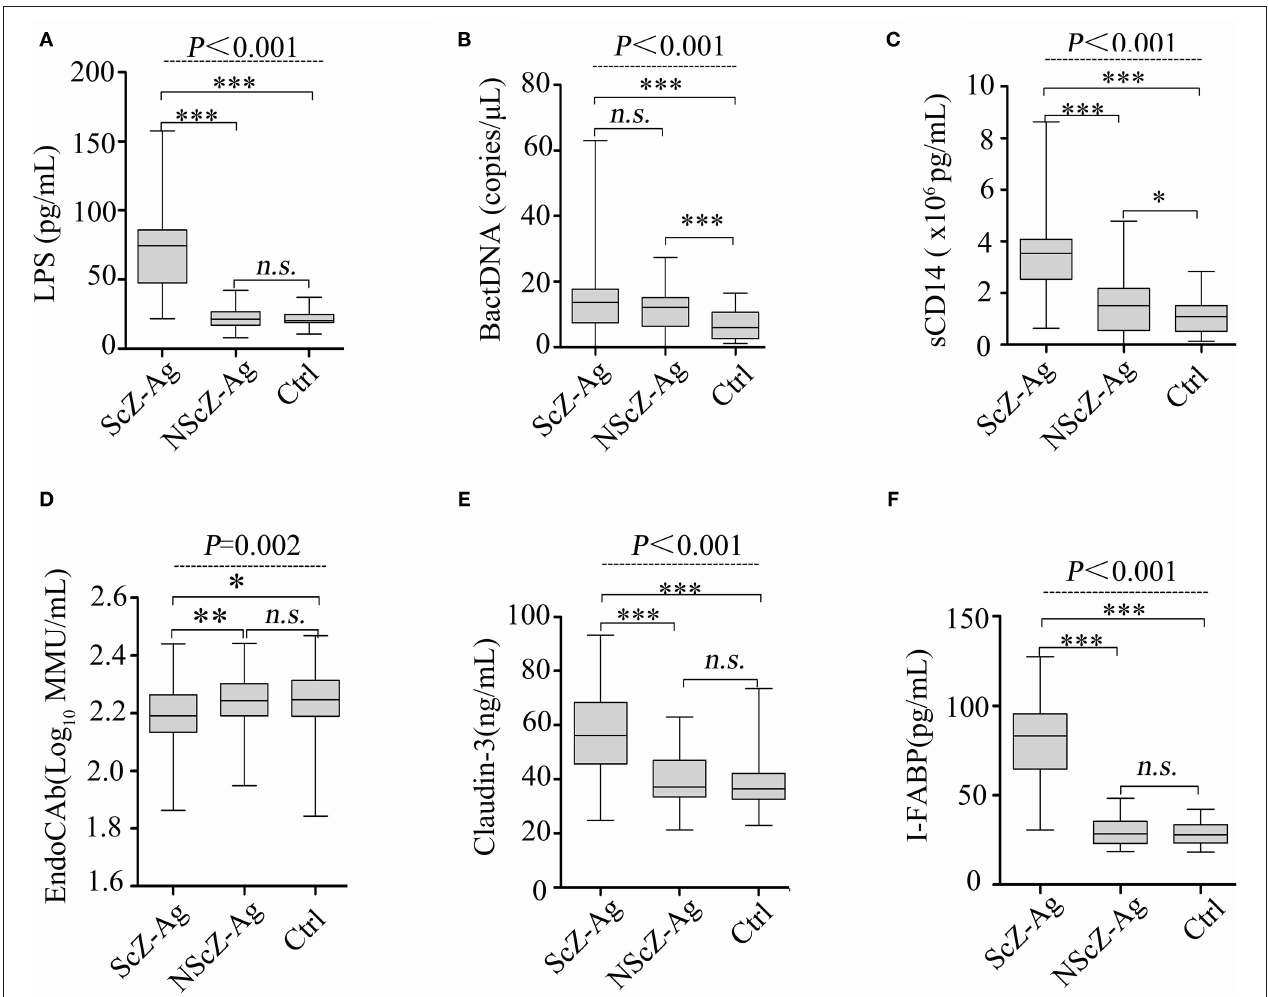
FIGURE 3 | Serum levels of LPS (A) , BactDNA (B) , sCD14 (C) , EndoCAb (D) , Claudin-3 (E) and I-FABP (F) among the three groups. LPS, lipopolysaccharide; BactDNA, bacterial DNA; sCD14, soluble CD14; EndoCAb, endotoxin core antibody; I-FABP, intestinal fatty acid-binding protein. Data were presented as boxplots. In post-hoc analysis using Bonferroni’s multiple comparison test, n.s. > 0.05, * P < 0.05, *** P < 0.001 analysis using